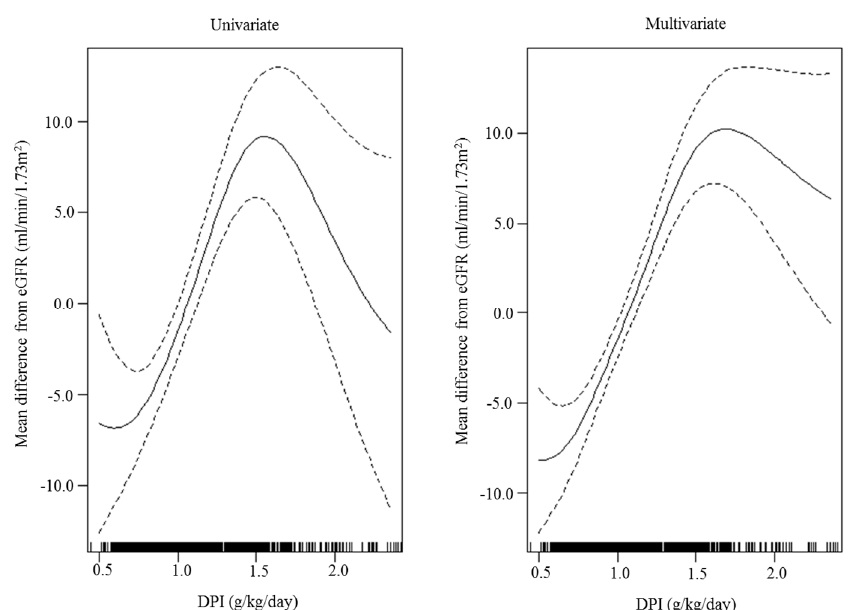
Figure 1. Generalized additive model (GAM) plot for Gaussian distribution between dietary protein intake (DPI) and estimated glomerular filtration rate (eGFR). The solid and dashed lines are the spline curve and its 95% confidence intervals, respectively. The upper ( ≥ 2.36 g/kg/day) and lower 1% (<0.5 g/kg/day) of DPI were truncated. The covariates in the multivariate GAM analysis were age, sex, current smoking, alcohol drinking, hypertension, diabetes, causes of chronic kidney disease, urine protein to creatinine ratio, blood urea nitrogen, bilirubin, hemoglobin, body mass index, cholesterol, estimated skeletal muscle mass, and serum albumin.